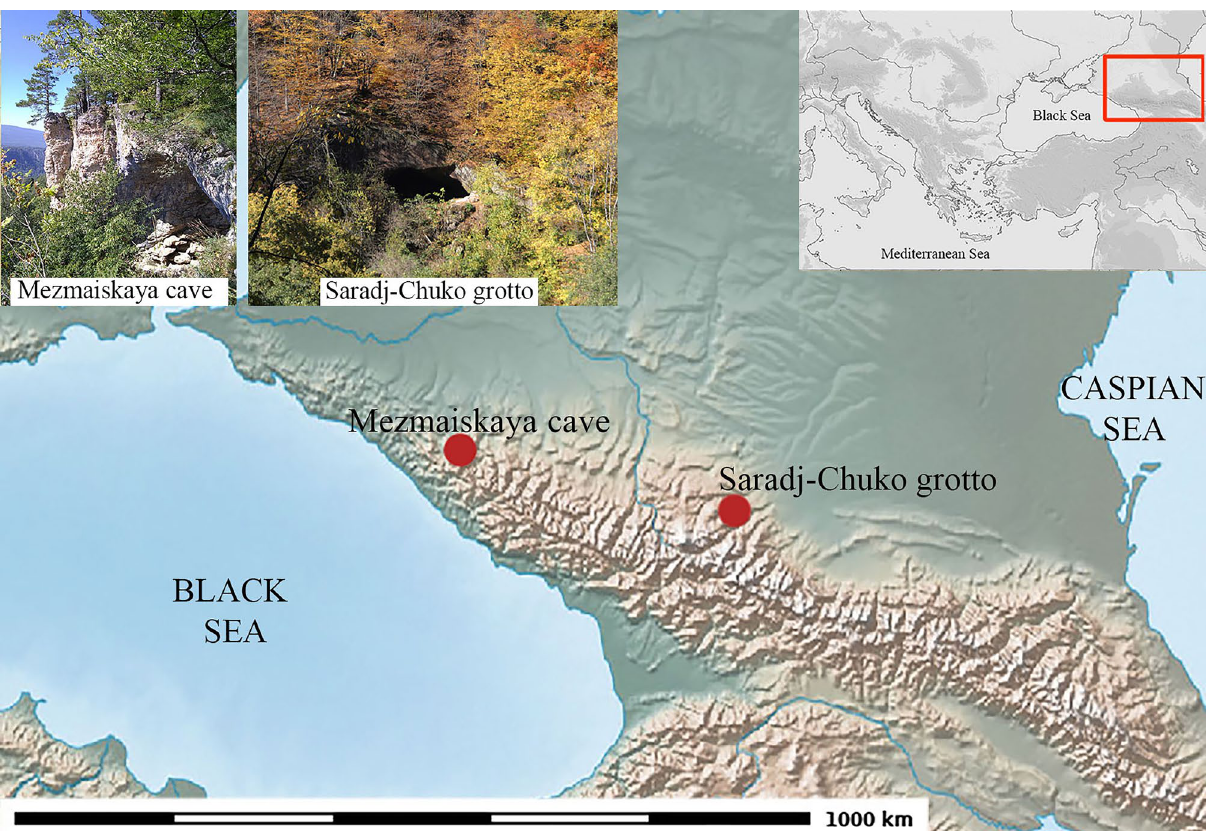
Figure 1. Map of the Caucasus showing the location of Mezmaiskaya cave and Saradj-Chuko grotto. Data: Natural Earth. Figure produced using GRASS GIS 7.8 and Inkscape